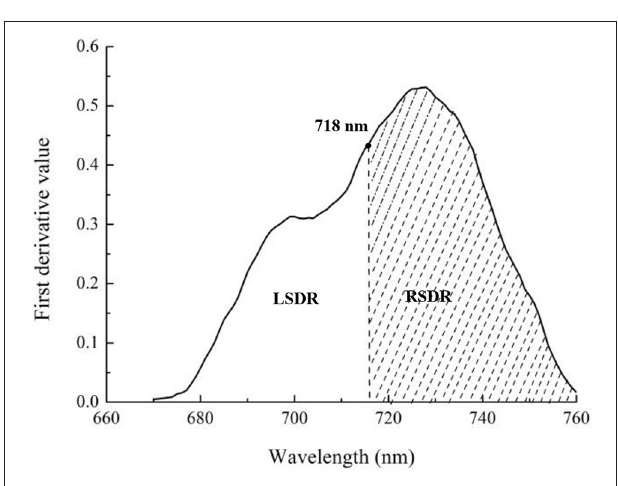
FIGURE 3 | The division of the whole red-edge double-peak area into left and right single peak